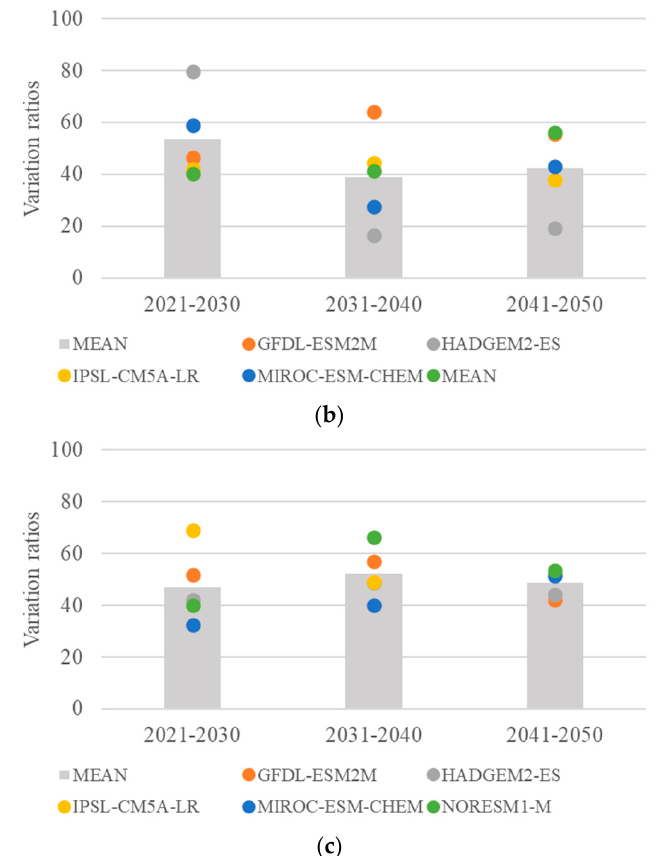
Figure 20. Predicted, decadal variation ratios under different climate scenarios: ( a ) RCP2.6, ( b ) RCP4.5, and ( c ) RCP8.5.